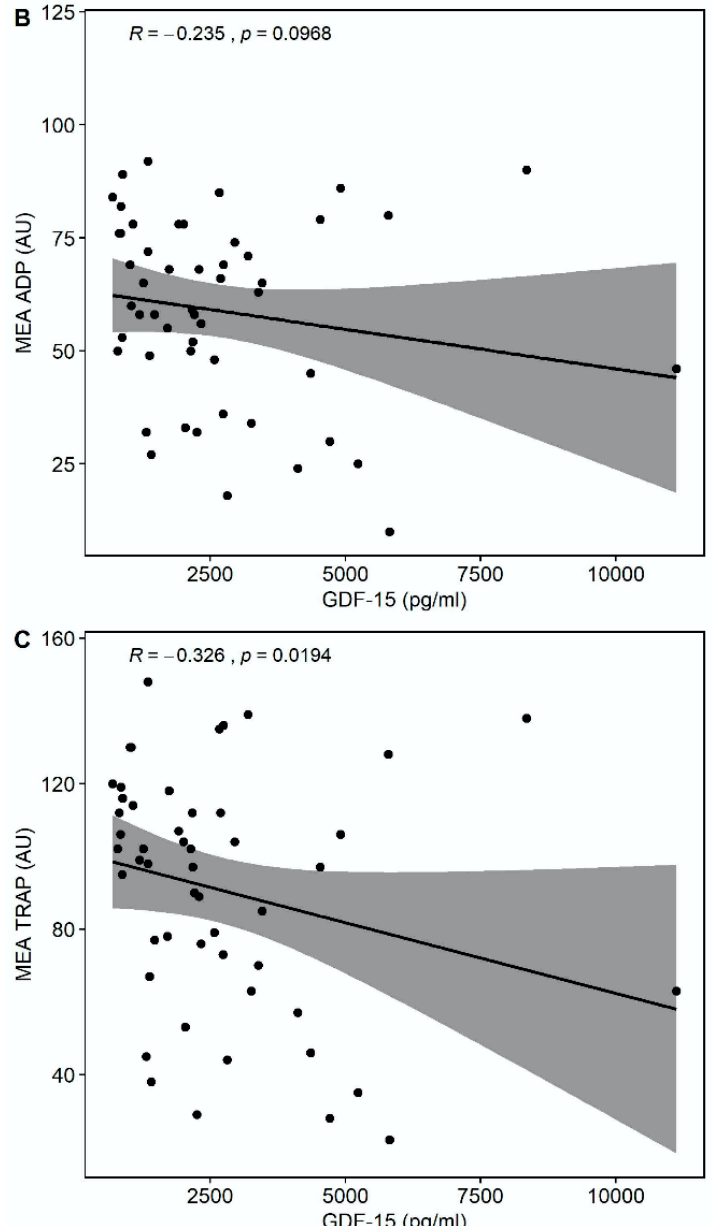
Figure 3. Correlations of GDF-15 with platelet aggregation by multiple electrode aggregometry (MEA). ( A ) Scatter plot showing GDF-15 ( x -axis) versus arachidonic acid (AA)-inducible platelet aggregation by MEA ( y -axis). ( B ) Scatter plot showing GDF-15 ( x -axis) versus adenosine diphosphate (ADP)-inducible platelet aggregation by MEA ( y -axis). ( C ) Scatter plot showing GDF-15 ( x -axis) versus thrombin receptor-activating peptide (TRAP)-inducible platelet aggregation by MEA ( y -axis).